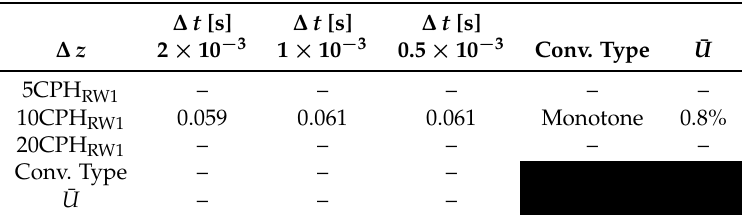
Table A3. Results of the temporal convergence study for RW2 ( T = 1.4 s, H = 0.060 m).